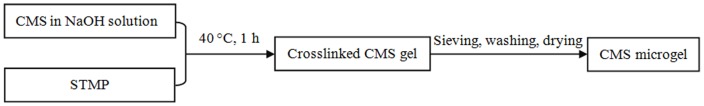
Scheme of preparing CMS microgels.